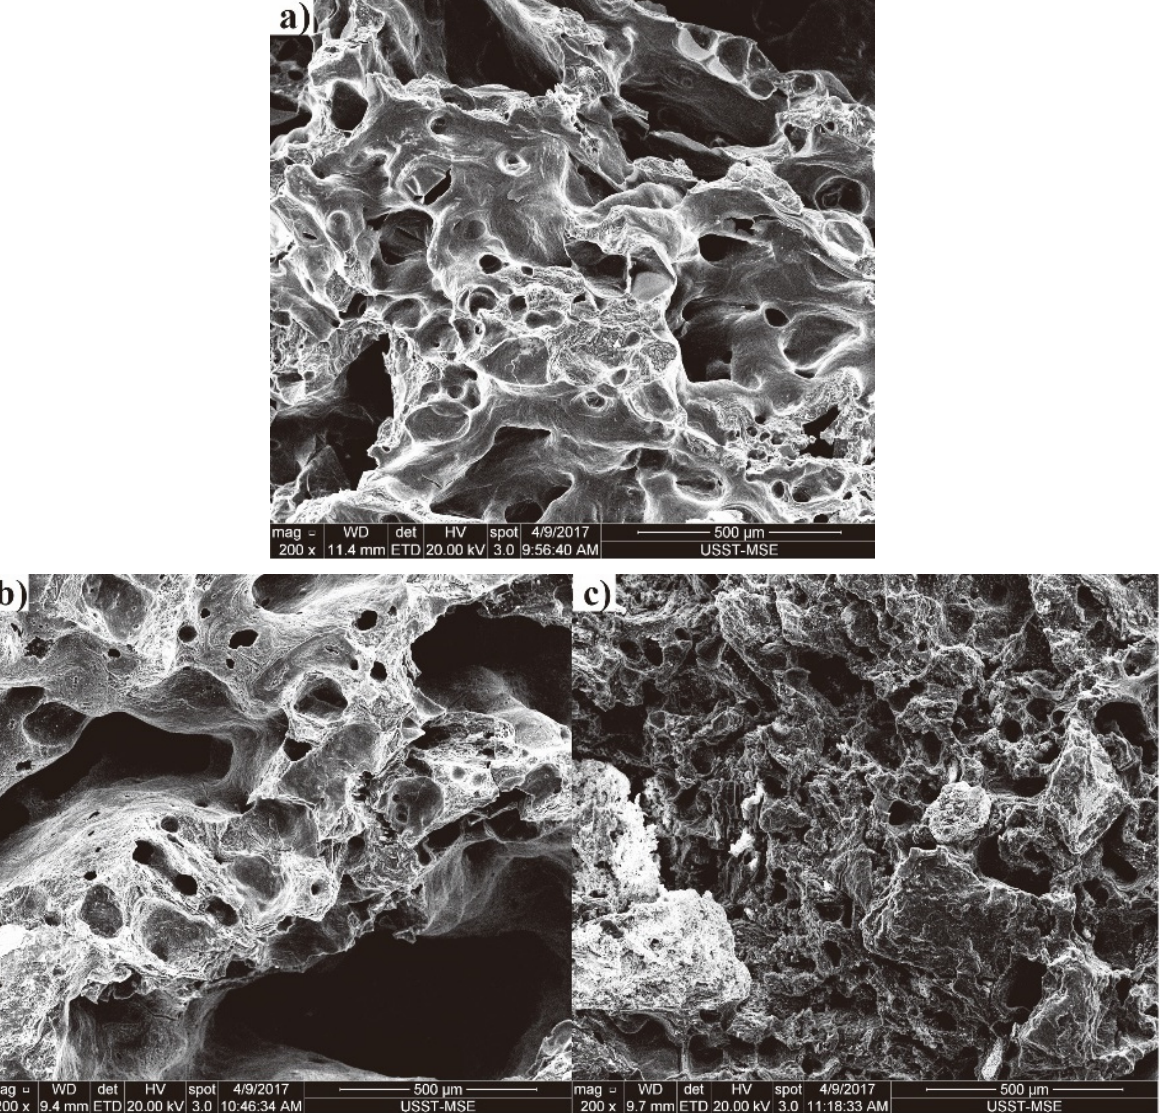
Figure 3. The SEM images of C2: ( a ) raw, ( b ) larger pores; ( c ) after reaction under T1 and